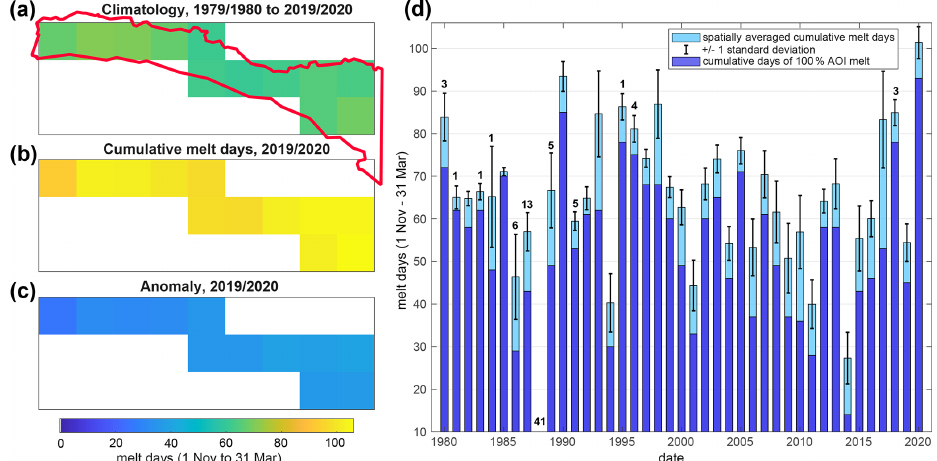
Figure 3. Microwave-radiometer-derived cumulative melt days over the northern GVIIS AOI (see Fig. 1b for location, red outline) from 1 November to 31 March. (a–c) Maps of surface and near-surface melt days per 25km grid cell. The relative location and shape of the study’s AOI is shown by the red outline. White cells are out of the AOI. (a) Mean cumulative melt days for each 25km grid cell for austral summers from 1979/1980 to 2019/2020, apart from 1987/1988 due to data unavailability. (b) Cumulative melt days per grid cell in the 2019/2020 austral summer. (c) Anomaly of the 2019/2020 melt season (i.e. b minus a ). (d) Light blue bars represent spatially averaged (i.e. over the 12 grid cells in the AOI) cumulative melt days for each austral summer from 1979/1980 to 2019/2020 (apart from 1987/1988). The x axis dates indicate the second year of each austral summer, e.g. 2020 corresponds to the 2019/2020 season. Black error bars show ± 1 standard deviation from the spatially averaged cumulative melt days. Dark blue bars show cumulative days when the melt extent is 100% of the AOI for each summer from 1979/1980 to 2019/2020. For melt seasons with missing data, the total number of missing data days is indicated by the black number above the corresponding bar.